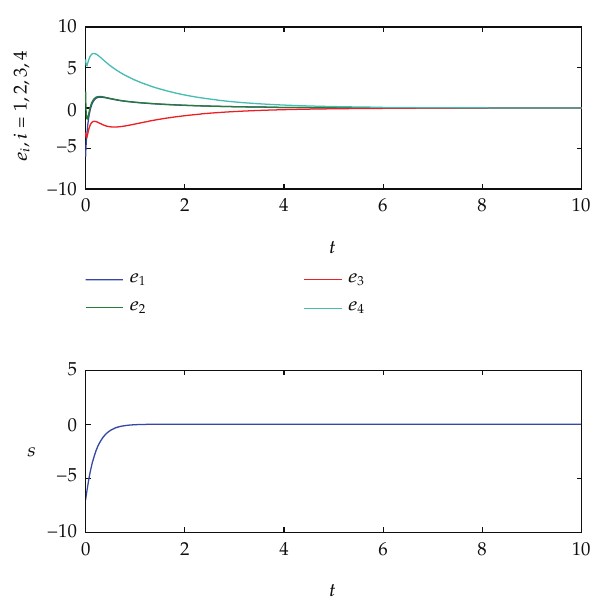
Figure 1: The evolvement of error system and sliding